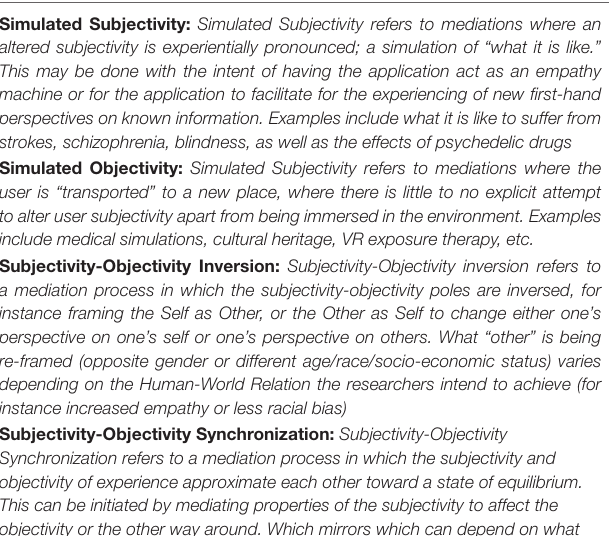
TABLE 3 | Overview of User-Environment Relations from